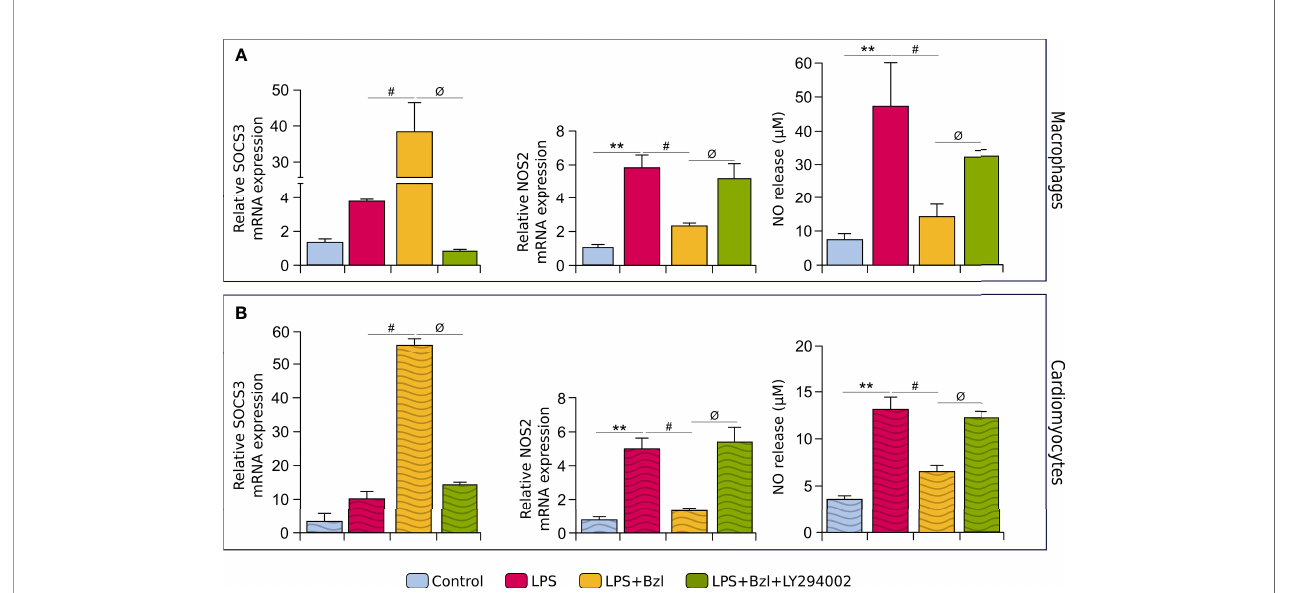
FIGURE 3 | RAW 264.7 macrophages (A) and neonatal primary cardiomyocytes (B) were treated with 30 m M LY294002, a non-isoform-selective inhibitor of PI3K, 30 min before the addition of 15 m M benznidazole (Bzl). Cells were stimulated with 10 µg/mL of LPS 30 min after Bzl treatment. After 48 h, NOS2 mRNA levels was analyzed by RT-qPCR and normalized against b -actin mRNA and NOx levels were quanti fi ed by the Griess reaction in culture supernatants. After 24 h, SOCS3 mRNA level was analyzed by RT-qPCR and normalized against b -actin mRNA. Results are expressed as the mean of 3 independent experiments (n=3, 5 replicates/ treatment) ± SEM. **P < 0.001 vs. control cells, # P < 0.05 vs LPS-stimulated cells. f P < 0.05 vs. Bzl-treated and LPS-stimulated cells.